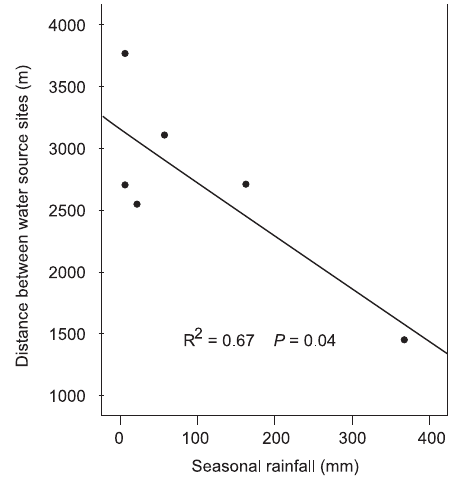
Fig. 7. The significant linear relationship between the maximum distance between water source sites and seasonal